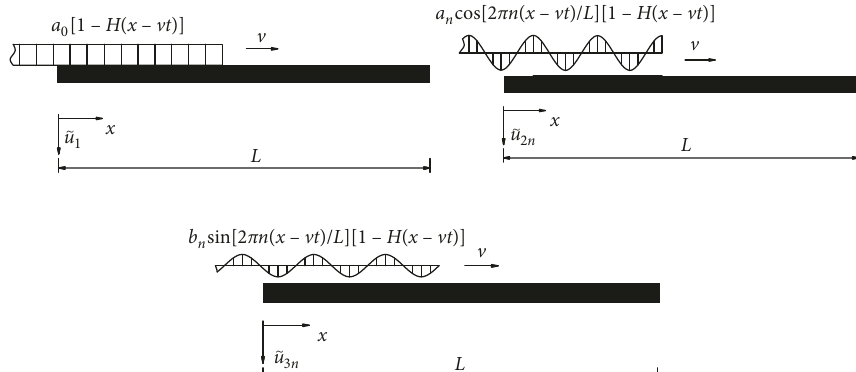
Figure 2: Base models of the single-span beam under moving distributed force. Beam under a strip of endless (a) uniform distributed force, (b) cosine form distributed force, and (c) sine form distributed force.